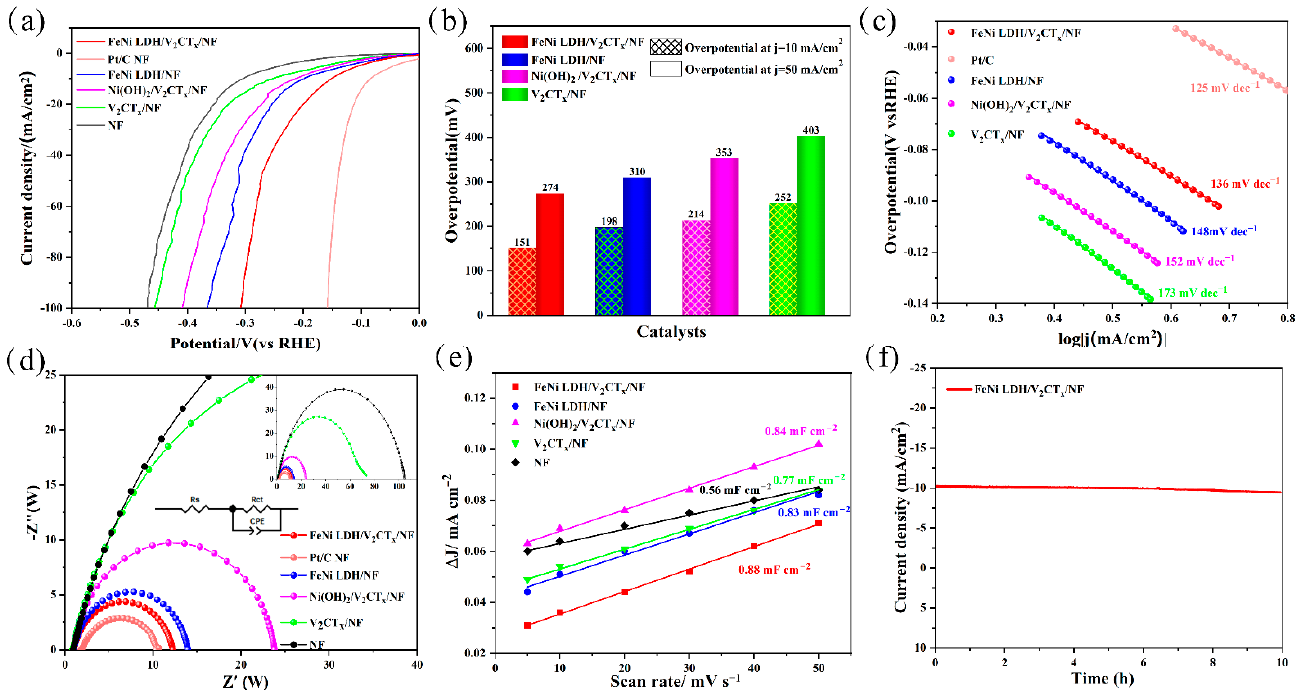
Figure 4. HER performances of prepared electrocatalysts. ( a ) LSV curves. ( b ) The overpotential of electrocatalysts. ( c ) Tafel plots. ( d ) EIS patterns. ( e ) C dl of samples. ( f ) Stability measurements of FeNi LDH/V 2 CT x /NF.